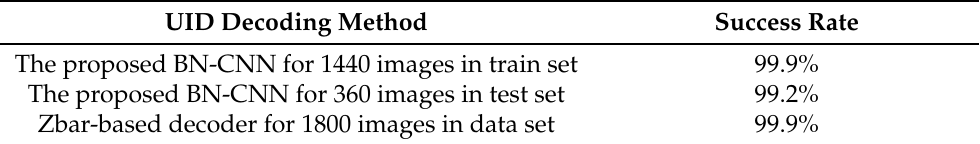
Table 1. The success rate of UID decoding using the proposed BN-CNN versus the Zbar-based